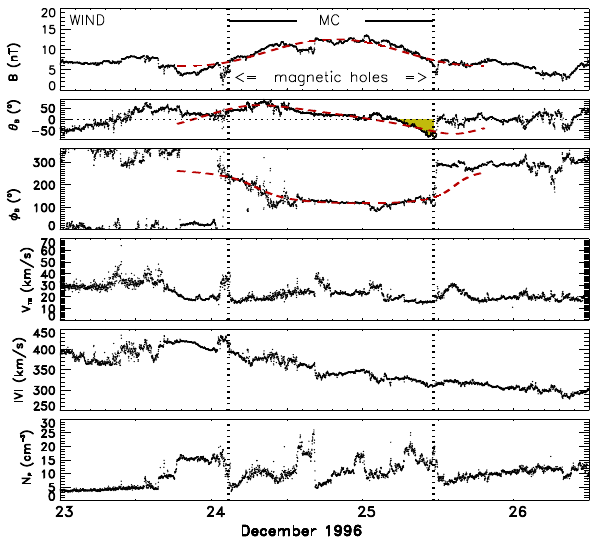
of Fig. 1 (but without the B X,Y,Z components) for the case of the 24 December 1996 MC, where again the dashed curves are model-fits. Especially noticeable are: the nearly symmetrical magnetic field intensity within the MC, the magnetic holes at the MC boundaries (seen in the B-profile), and the irregular patterns in thermal speed and density. For example, the density profile differs dramatically from those in A and B of Fig. 1, and is somewhat different from that in C of that figure. Notice that this MC is in the N → S Category (in contrast to the MC in Fig. 1A which is a S → N type – see Table 3). For an N → S type there is the possibility of predicting the point where B z is min. (usually a southward field), based on the early part of the MC, for D st forecasting. Holes (when they exist) and directional discontinuities are very helpful in choosing the proper MC boundaries. The brief region shaded in yellow is where the observed B z component is